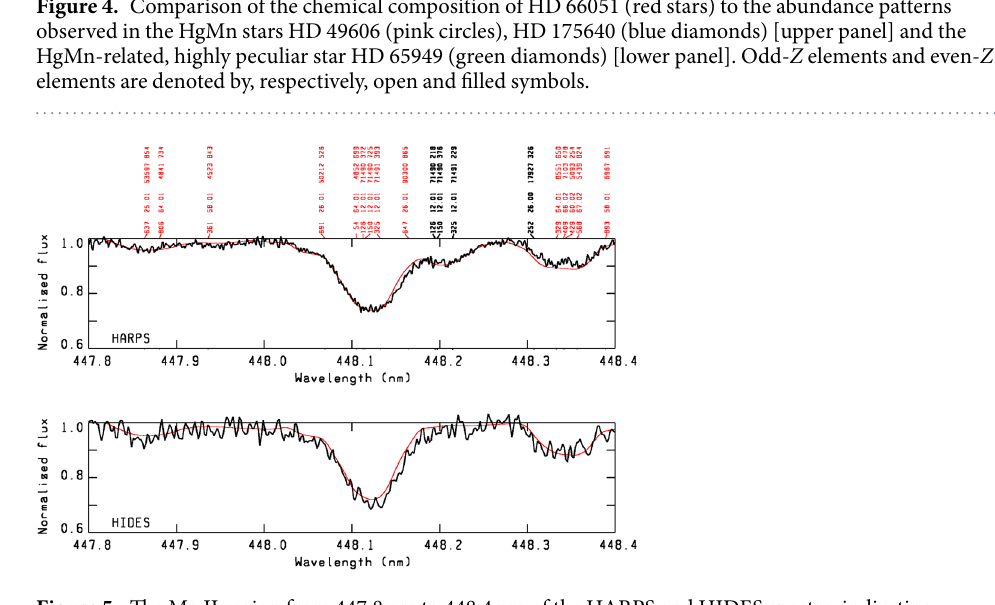
Figure 5. The Mg II region from 447.8 nm to 448.4 nm of the HARPS and HIDES spectra, indicating some of the lines identified in the primary star (red identifications) and the secondary component (black identifications). The observed spectra are shown in black, the synthetic spectra are indicated by the red